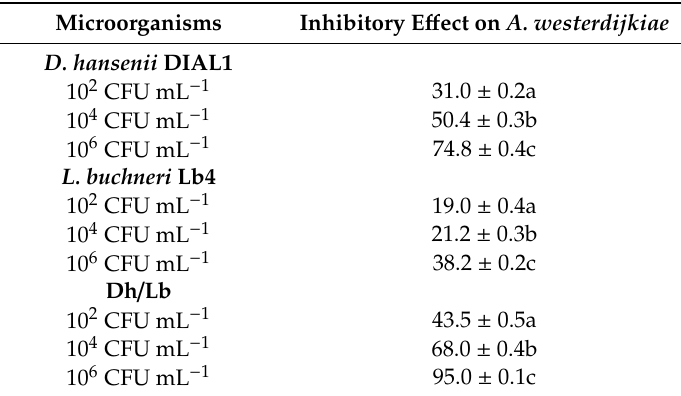
Table 4. Percentage of inhibitory e ff ect of di ff erent concentration of D. hansenii and L. buchneri vs A. westerdijkiae co-inoculated in agar